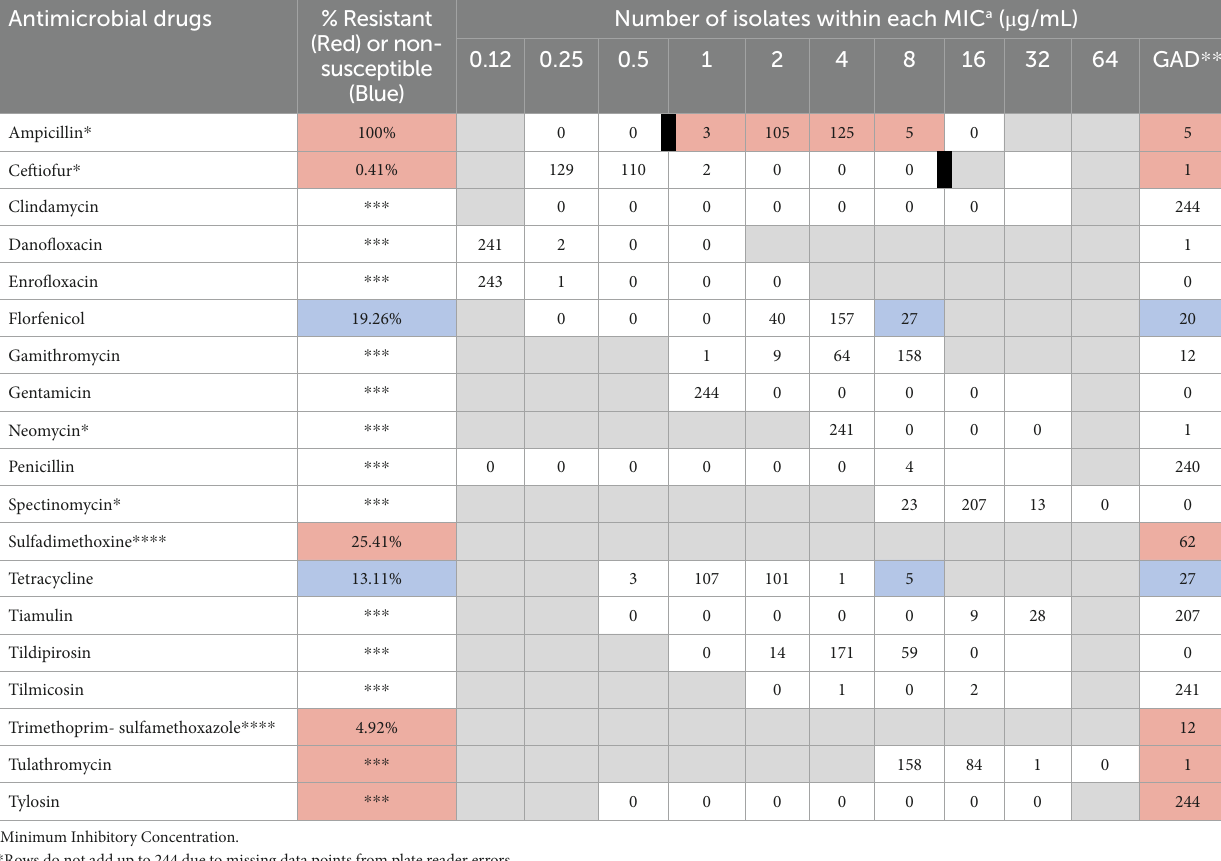
TABLE 3 Distribution of 244 E. coli isolates inhibited by various concentrations of select antimicrobials. Antimicrobial susceptibility was conducted on E. coli isolated from fecal samples during a cross-sectional study on prevalence of antimicrobial resistance to E. coli and Enterococcus from cow-calf operations in northern California between July 2019 and August 2020.